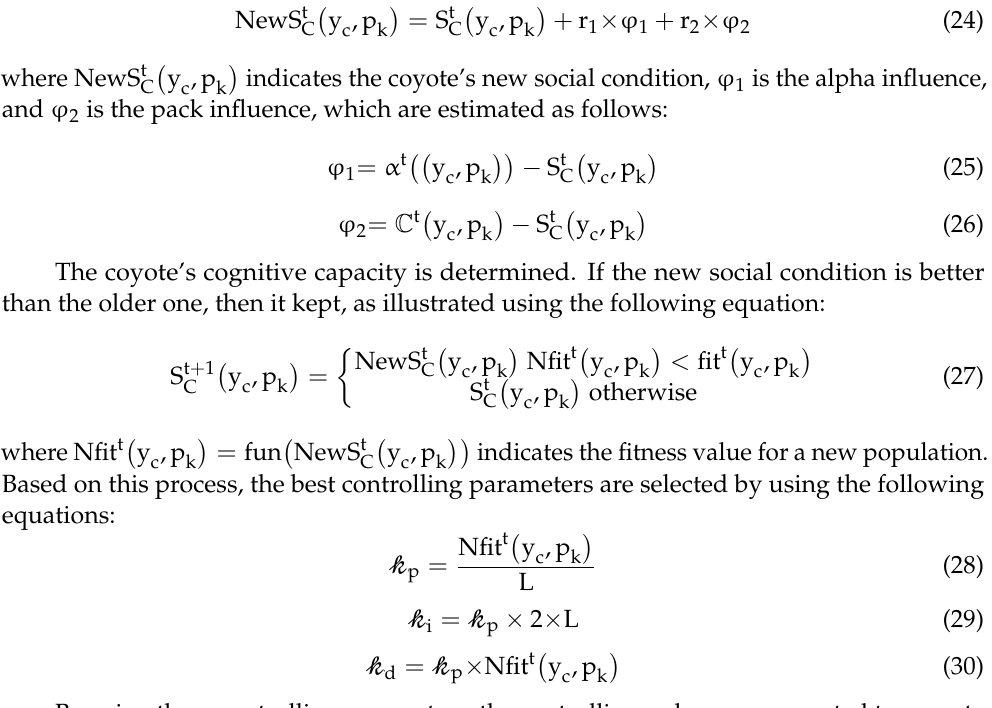
Figure 4. Equivalent circuit model o f isolated high voltage gain DC−DC converter. Algorithm 2 Coyote Optimized Converter Control (COCC).